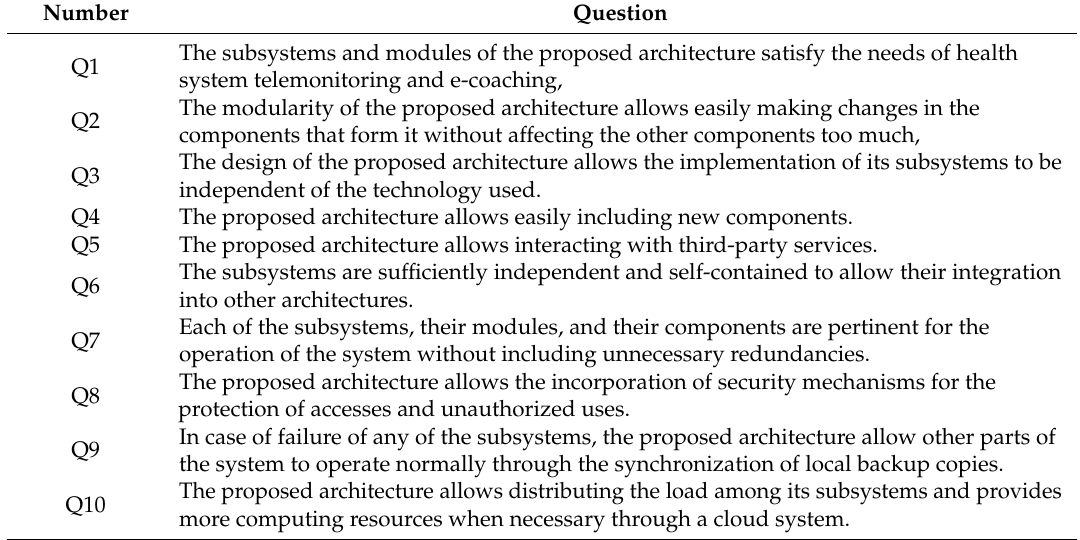
Table 1. Validation survey questions.